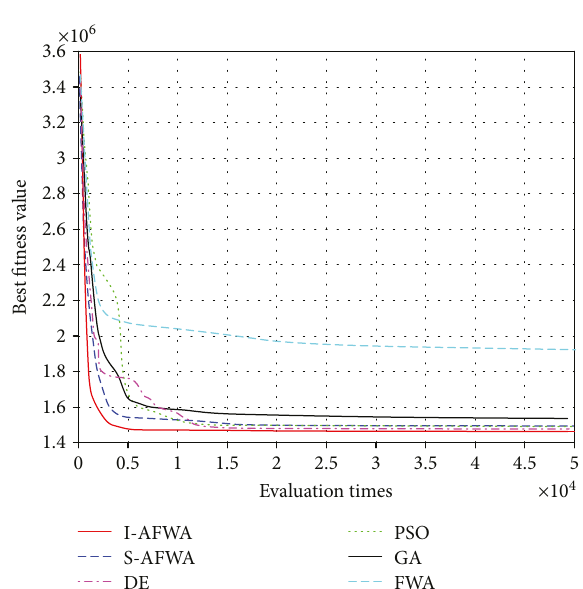
Figure 8: The average convergence curves of the fi tness function for each algorithm in minimum total heat reentry trajectory